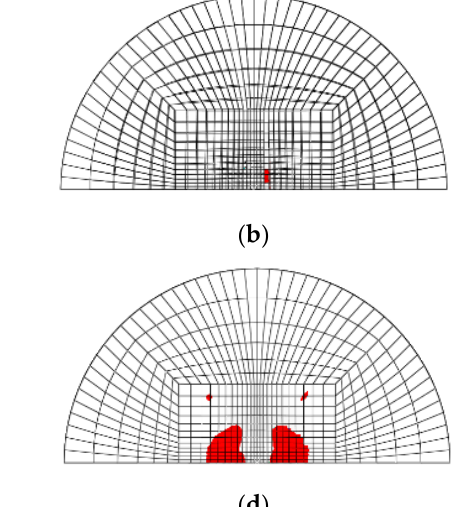
( d ) Figure 23. Fiber tension failure (FTF) in the composite layers of GLARE 5-2/1 with [0 ° /90 ° /90 ° /0 ° ] after applying the second impact energy of 16 J; ( a ) 2D failure model (0.392 ms), ( b ) 2D failure model (1.83 ms), ( c ) 3D failure model (0.392 ms), ( d ) 3D failure model (1.96 ms). 5. Conclusions In this paper, the multiple impact behaviors of aluminum 2024-T3 and GLARE 5-2/1 with diverse total impact energy were studied through experiments and finite element simulations. Three different multiple impact energies of 8 J (2 × 4 J), 16 J (2 × 8 J), and 26 J (2 × 13 J) were considered for aluminum 2024-T3 and GLARE 5-2/1 to create BVID and CVID. In the case of BVID at 8 J and 16 J, aluminum 2024-T3 and GLARE 5-2/1 showed plastic deformation dents on the outer aluminum layer. The CVID at 26 J for aluminum